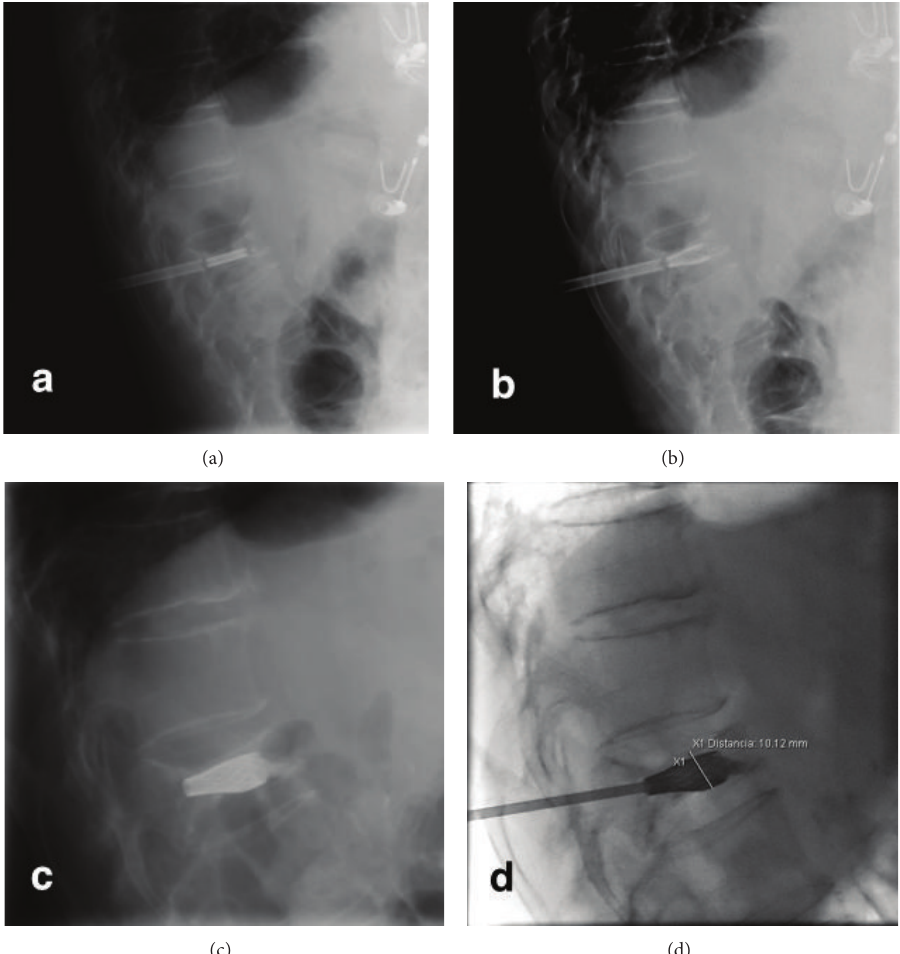
Figure 3: Lateral fluoroscopic projections showed progressive deployment of vertebral body stent with vertebral size augmentation up to